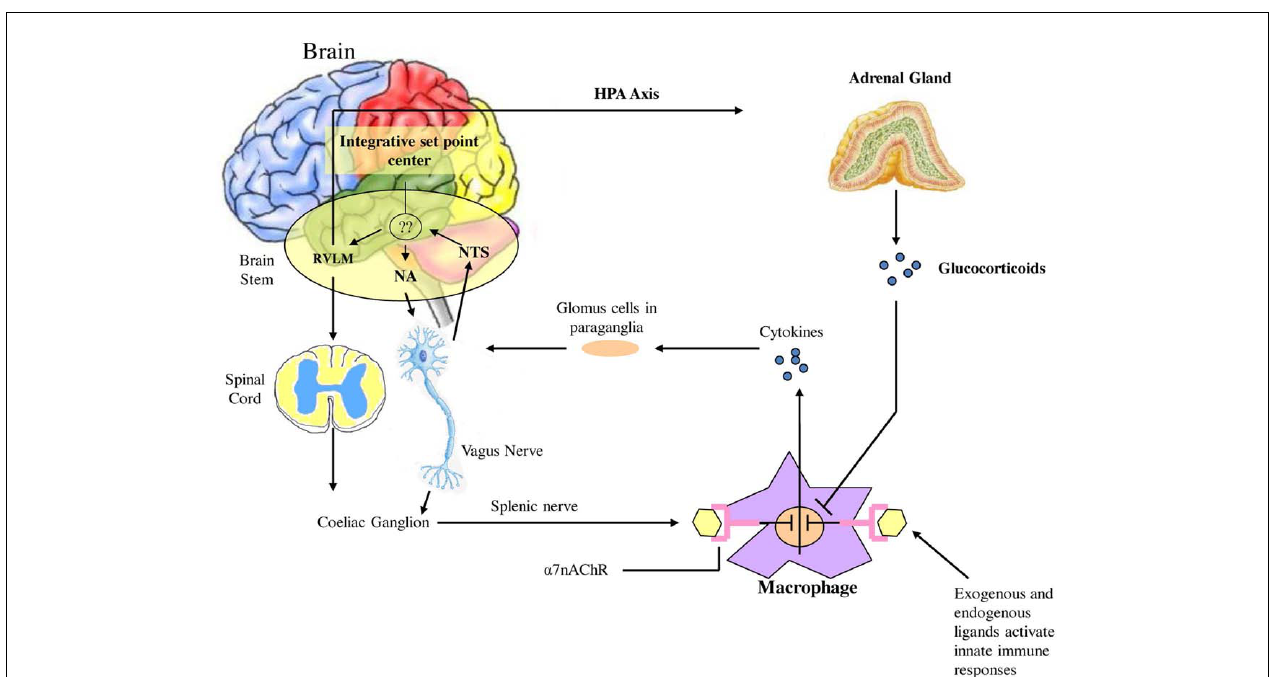
Stimulation of the vagus inhibits this activation by acetylcholine binding to the α 7nACHR receptor which curtails the response. Also shown is the coactivation of the hypothalamic pituitary axis with release of glucocorticoids which also modulate the inflammatory response. It is however unclear how this set point is determined in the body but what is clear is that autonomic modulation of inflammation can be achieved by altering sympathetic/parasympathetic